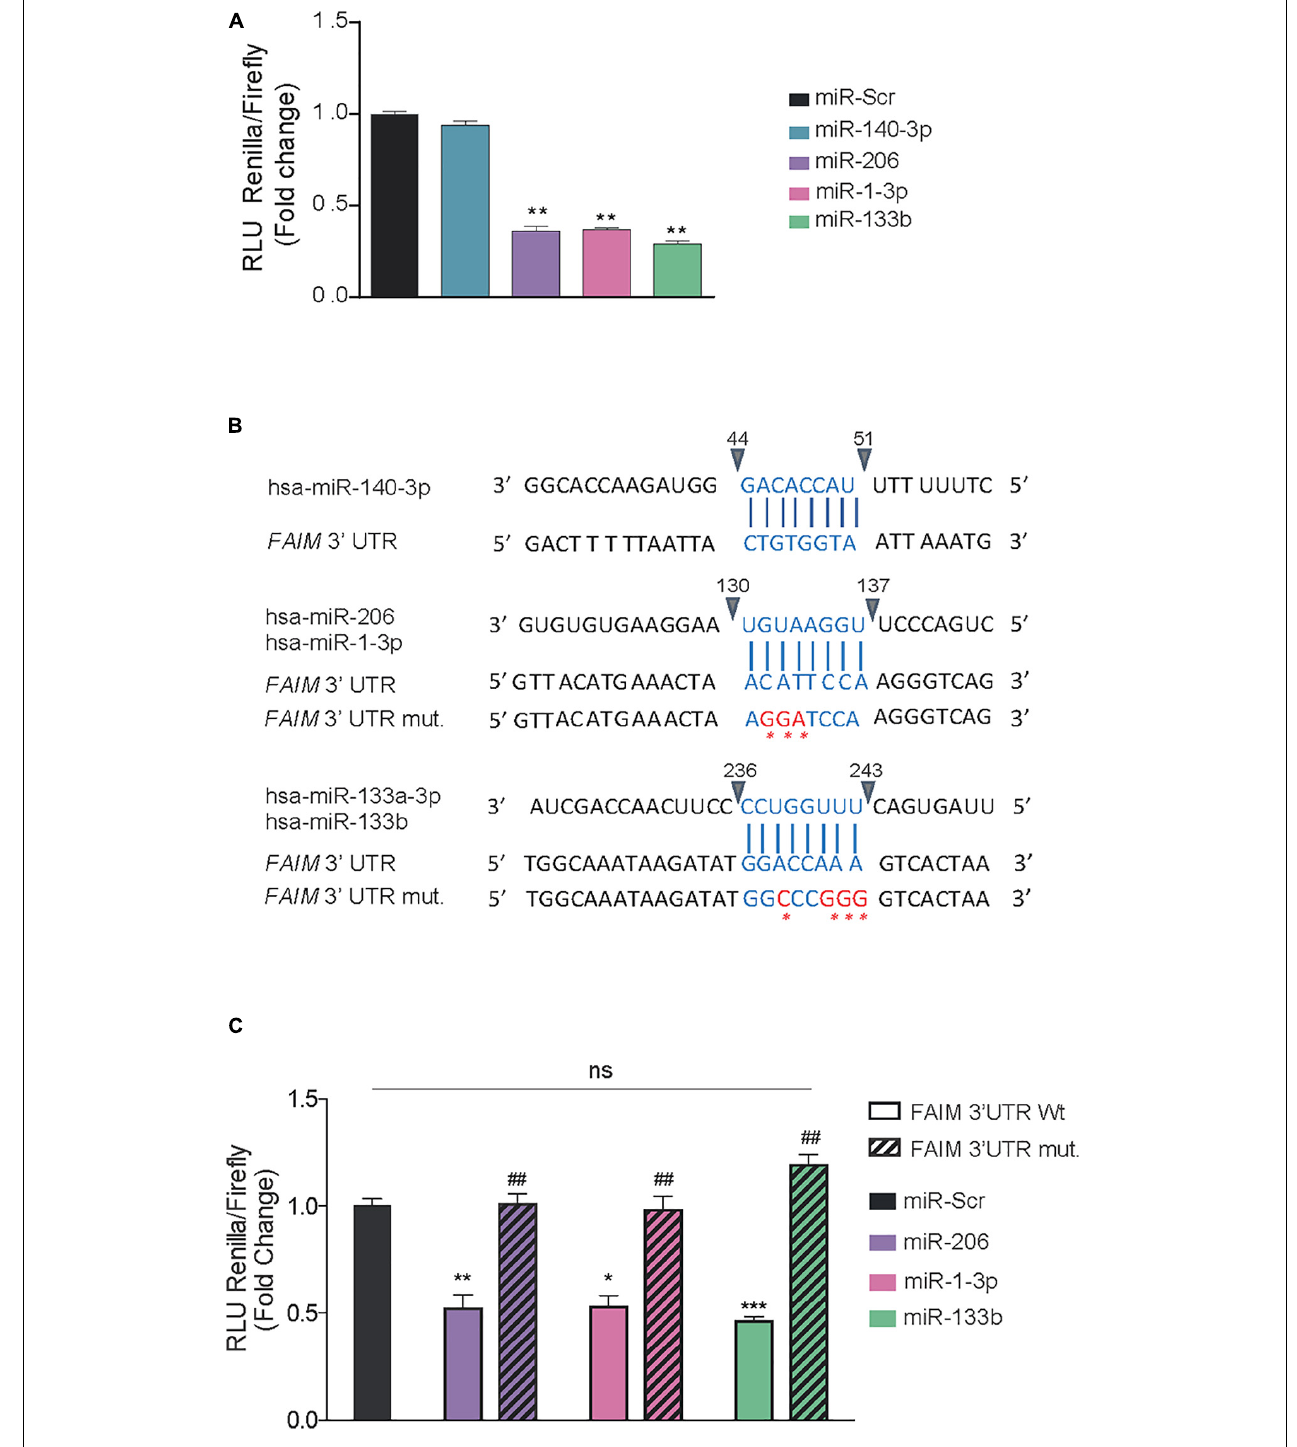
FIGURE 2 | miR-206, miR-1-3p, and miR-133b bind directly to FAIM 3 (cid:48) UTR . (A) Dual luciferase activity assay in HEK293T cells after the transfection of 25 nM of the indicated miRNAs using psiCheckTM-2 vectors encoding the wild type 3 (cid:48) UTR of FAIM. (B) Schematic representation of the indicated miRNA binding sites in the wild type (wt) and mutated (mut) 3 (cid:48) UTR of FAIM. The mutated nucleotides are indicated in red. (C) Dual luciferase activity assay in HEK293T cells after the transfection of 25 nM of the indicated miRNAs using psiCheckTM-2 vectors encoding the wild type and mutated forms of FAIM 3 (cid:48) UTR. Graph represents the values of luciferase activity and are the mean of three independent experiments ± SEM. * P < 0.05, ** P < 0.01, and *** P < 0.001, compared with control vector. ## P < 0.05 compared with the wild type 3 (cid:48) UTR of FAIM.